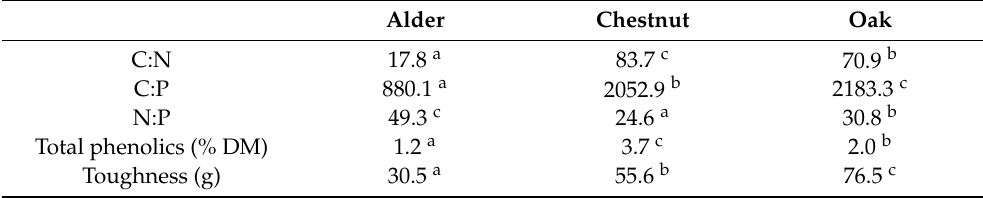
Table 1. Initial chemical and structural characteristics of the leaves of alder, chestnut, and oak (mean ± SE, n = 3). C:N, C:P, and N:P were calculated as molar ratios. For each parameter, different letters indicate significant differences between species (one-way ANOVA followed by Tukey’s HSD test; p < 0.05). Alder Chestnut Oak